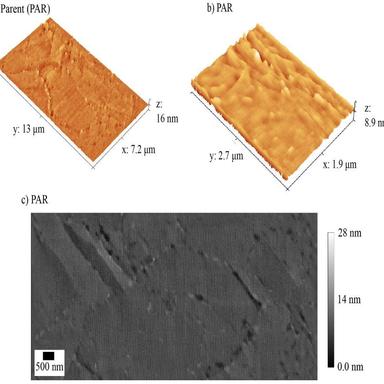
Selected large area HS-AFM images of the parent material.